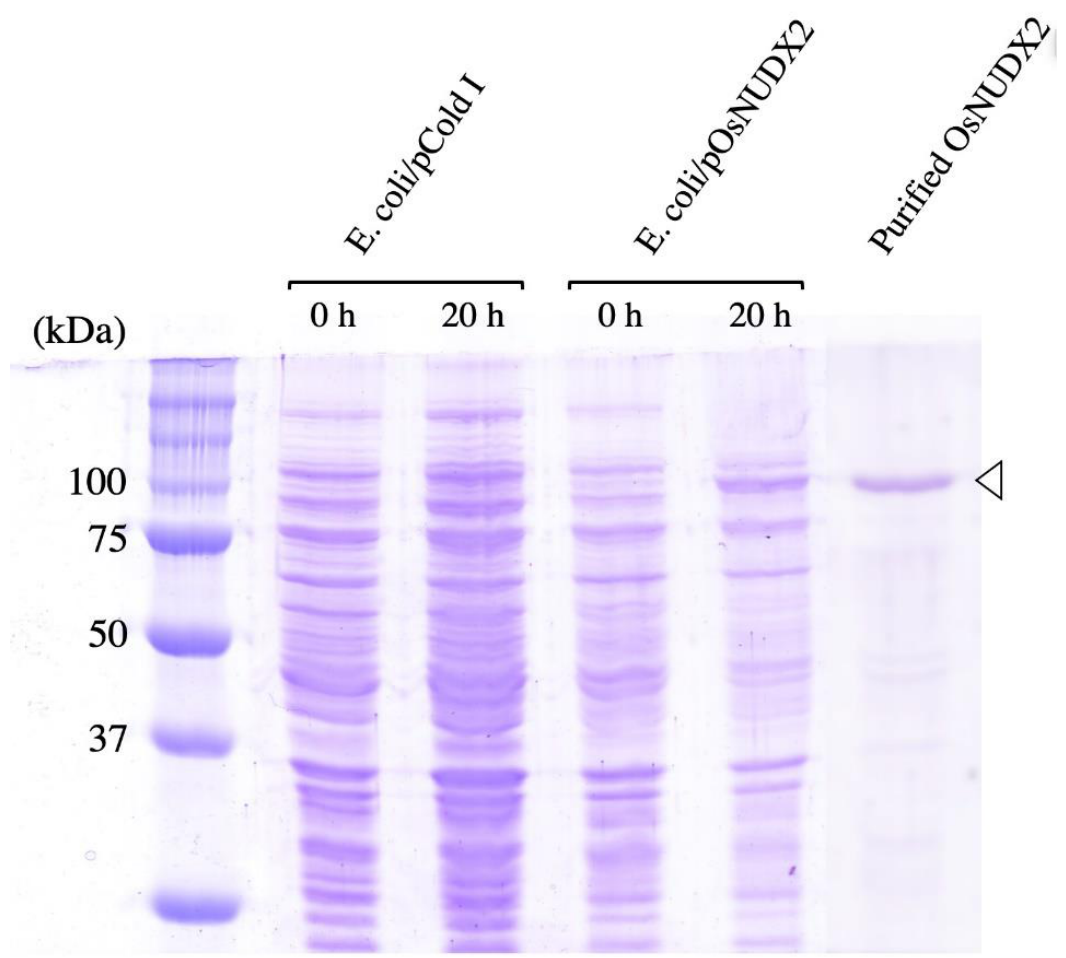
Figure 3. Production and purification of OsNUDX2 in E. coli cells using SDS-polyacrylamide gel. Total cell lysates of E. coli cells harboring pCold I and pOsNUDX2, before and after IPTG induction for 20 h, and purified OsNUDX2 were electrophoresed using 10% SDS-PAGE with the molecular mass marker series for calibration, with detection by Coomassie Brilliant Blue R-250 staining. An arrowhead indicates the OsNUDX2 protein.